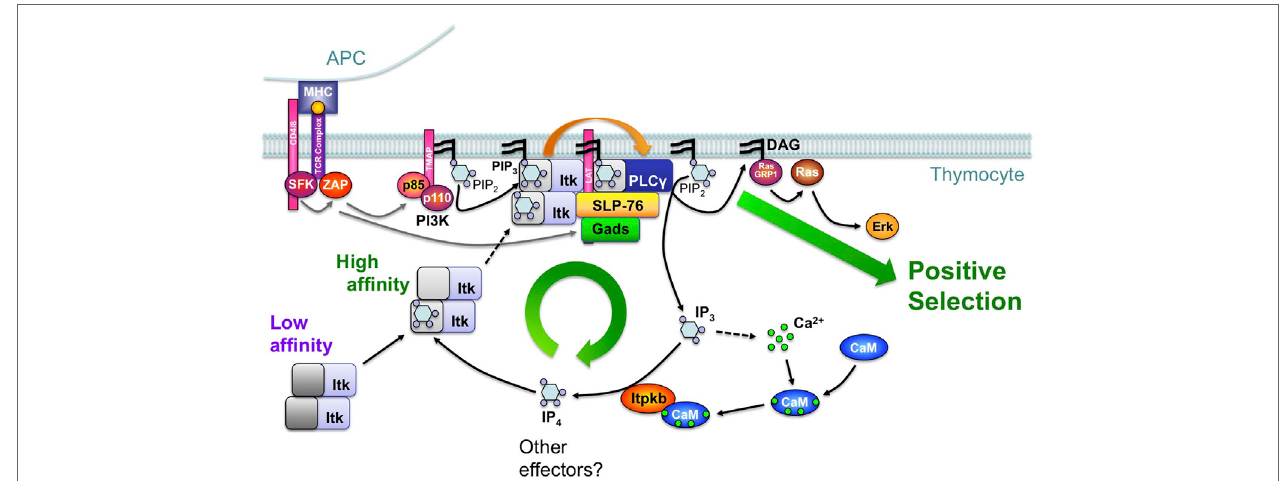
FigURe 8 | Feedback-activation of Itk/phospholipase-C γ 1 (PLC γ 1) by IP 4 may amplify mild T cell receptor (TCR) signals such that they can trigger thymocyte positive selection. Based on studies of Itpkb − / − mice and mathematical simulations of different signaling circuitries in DP cells (20, 21, 28, 56), we proposed a simplified model where TCR engagement on DP thymocytes activates proximal protein tyrosine kinases (SFK, ZAP), which then tyrosine-phosphorylate transmembrane adaptors (TMAPs, LAT). Among other events, this activates phosphoinositide 3-kinase (PI3K), which then phosphorylates membrane PIP 2 into PIP 3 . By binding to their PH domains, PIP 3 recruits PLC γ 1 and its upstream activator, the Tec-family protein tyrosine kinase Itk into the TCR signalosome which also contains LAT and the adaptors SLP-76 and Gads. In this model, Itk is oligomeric with low PH domain affinity for PIP 3 (dark gray). Therefore, initial Itk recruitment is limited and only triggers low-level PLC γ 1 activation. PLC γ 1 hydrolyzes PIP 2 into low amounts of the second messenger diacylglycerol (DAG) and IP 3 . IP 3 mobilizes Ca 2 + . Ca 2 + binds calmodulin (CaM) which then binds to and activates Itpkb and calcineurin (CaN) (118). CaN dephosphorylates and activates the transcription factor NFAT (data not shown) (119). Itpkb phosphorylates IP 3 into IP 4 . IP 4 binding to one Itk subunit allosterically increases the PH domain affinity of all Itk subunits for PIP 3 (light gray). This promotes Itk membrane recruitment, causing full PLC γ 1 activation and sufficient DAG-production to activate Ras/Erk and trigger thymocyte positive selection. Itpkb loss perturbs this feedback activation through decreased IP 4 production and Itk recruitment. As a result, insufficient DAG production impairs Ras/Erk activation and positive selection, causing a block of thymocyte development at the DP stage. Itpkb and IP 4 may have additional functions in DP thymocytes,